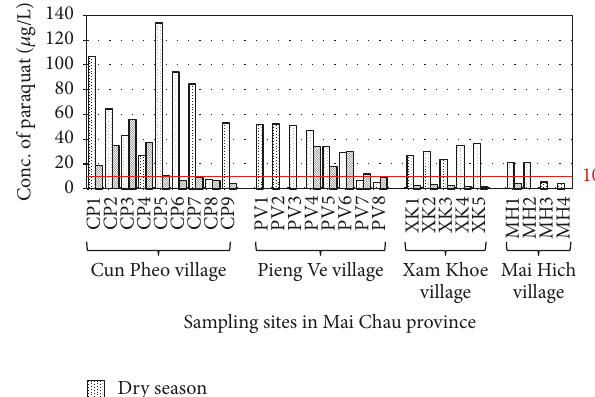
Figure 2: Concentration of paraquat ( 𝜇 g/L) in four villages (Cun Pheo, Pieng Ve, Xam Khoe, and Mai Hich) at Mai Chau province, the Northern